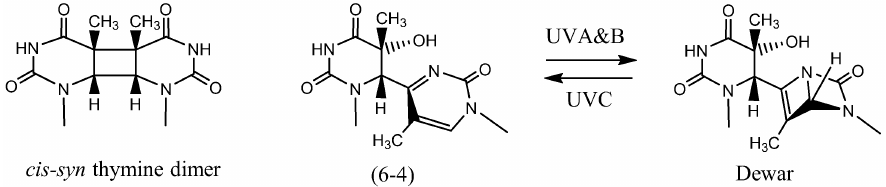
Figure 2. The chemical structures of UV light induced cis-syn thymine dimer, pyrimidine(6-4)pyrimidone and Dewar photoproducts formed by two adjacent thymines.